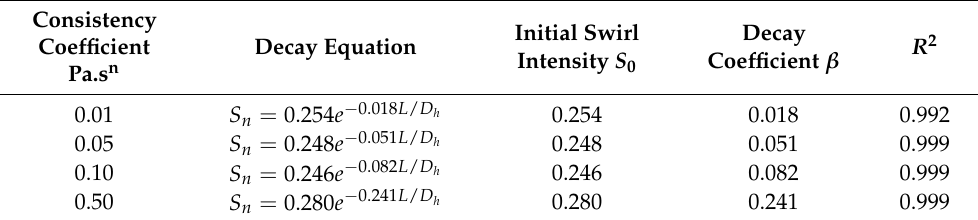
Figure 8. Decay law of swirl intensity of spiral flow induced by the hole cleaning device ( α = 0°) along the flow direction under different fluid consistency coefficients (numerical results). Table 4. Decay equation of spiral flow induced by the hole cleaning device ( α = 0°) under different fluid consistency coefficients (numerical results).